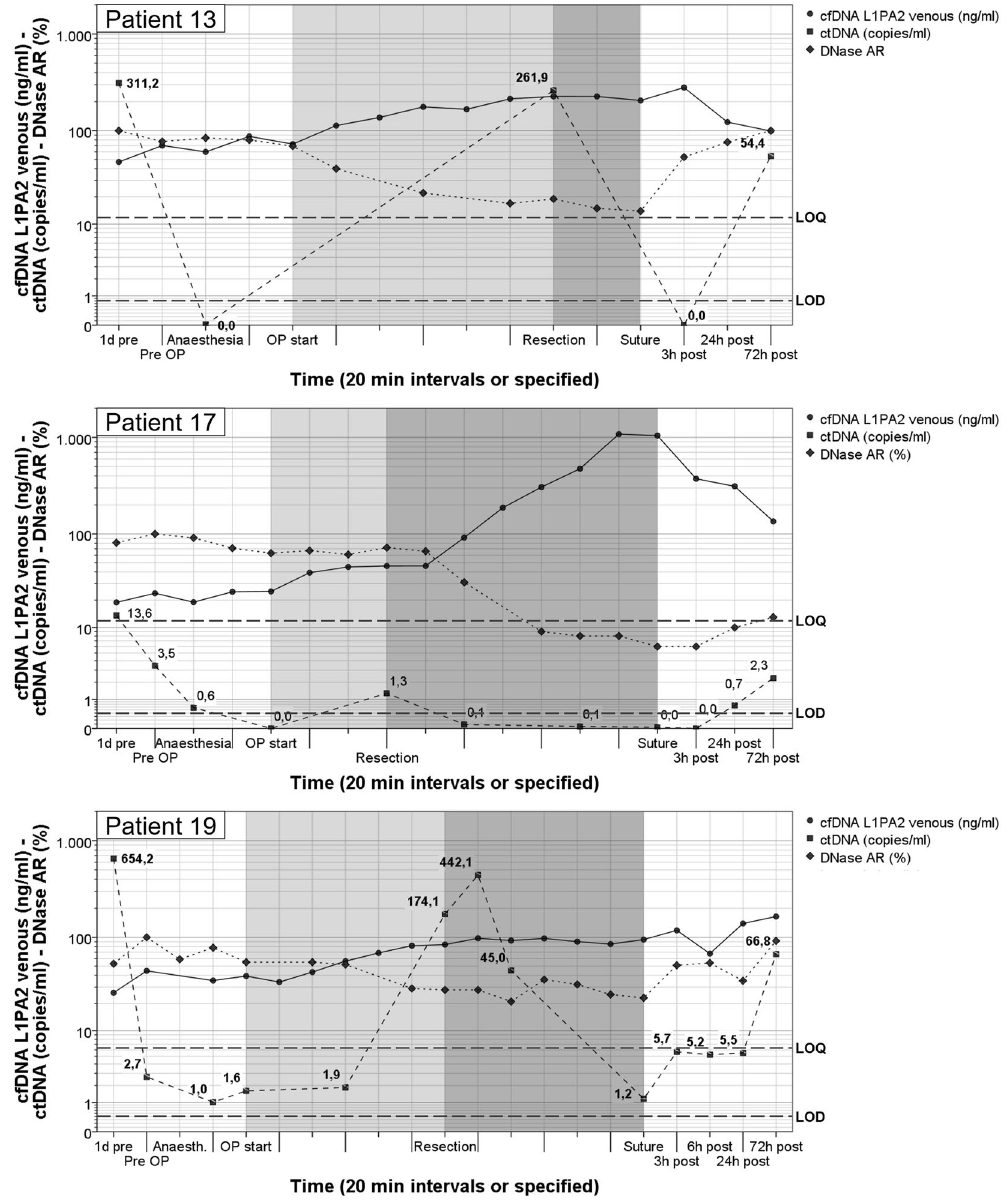
Figure 1. Curve progressions of cfDNA, ctDNA, and DNase 1 activity reduction over the course of surgery. In contrast to the cfDNA values, which steadily increased over the whole course of surgery, ctDNA concentrations decreased sharply during surgery and only increased briefly after resection of pathological tissues and then again gradually in the days following surgery. Changes in DNase 1 AR were inversely correlated to cfDNA development. LOQ and LOD in dashed lines refer to ctDNA values only. Phases of surgery are coloured in grey. Time intervals between samples are 20 minutes if not specified differently. The amount of taken samples was dependent on progress of